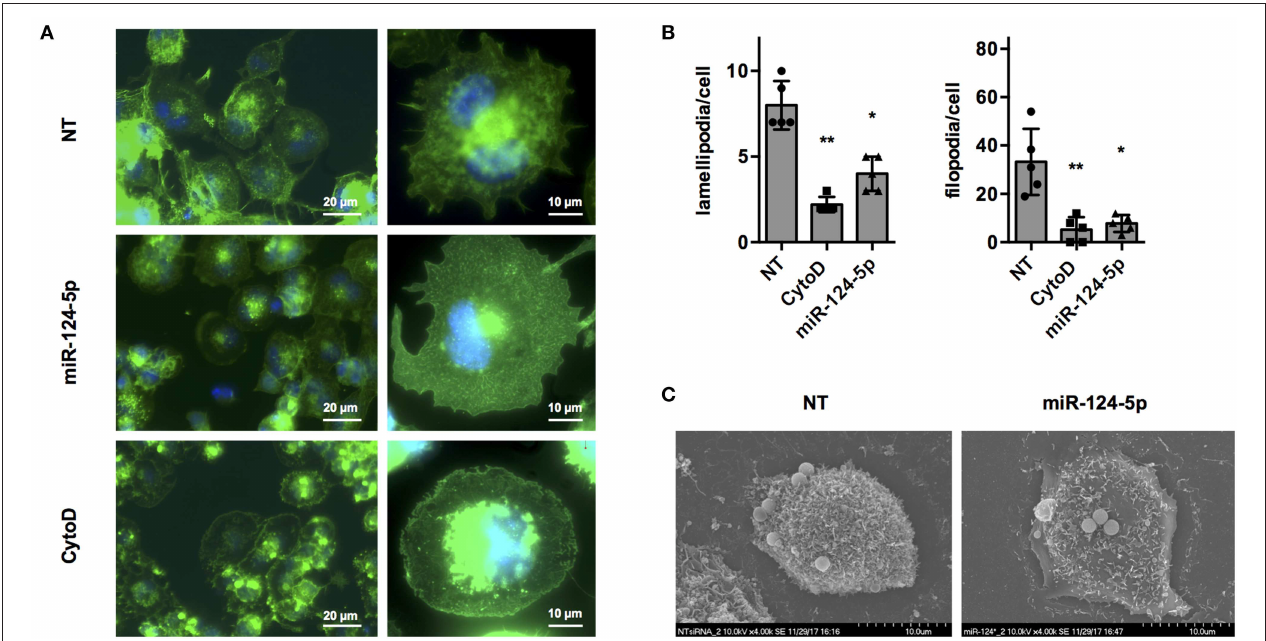
FIGURE 5 | Transfection with miR-124-5p alters cell morphology of PMA-activated THP-1 M 8 . (A) Fluorescence microscopy of PMA-activated THP-1 M 8 following the indicated treatments. Actin cytoskeleton was stained with Alexa Fluor 488-phalloidin and nuclei with Hoechst 33342. Images were acquired with a Zeiss AxioObserver Z1 using a 40 × (left panels; scale bars: 20 µ m) or a 100 × objective (right panels; scale bars: 10 µ m) and overlays of the fluorescence channels for phalloidin (green) and Hoechst (blue) are shown. (B) Quantitative analysis of lamellipodia and filopodia formed by PMA-activated THP-1 M 8 following the indicated treatments. Image analysis was performed as described in Supplementary Figure S5 . A total of 47–57 cells (depending on the condition) of n = 5 independent experiments were analyzed. Mean values for each experiment are indicated by symbols and the mean ± SD across experiments are indicated by a bar and whiskers. Statistical analysis was performed using repeated measures, one-way ANOVA with Geisser–Greenhouse correction. Dunnett’s post analysis was used to calculate p -values adjusted for multiple comparisons with the NT set as control condition (* p < 0.05; ** p < 0.01). (C) SEM of PMA-activated THP-1 M 8 following the indicated treatments. Images were acquired with a Hitachi S-5200 scanning electron microscope at 4,000 × magnification. Representative cells of n = 3 independent experiments are